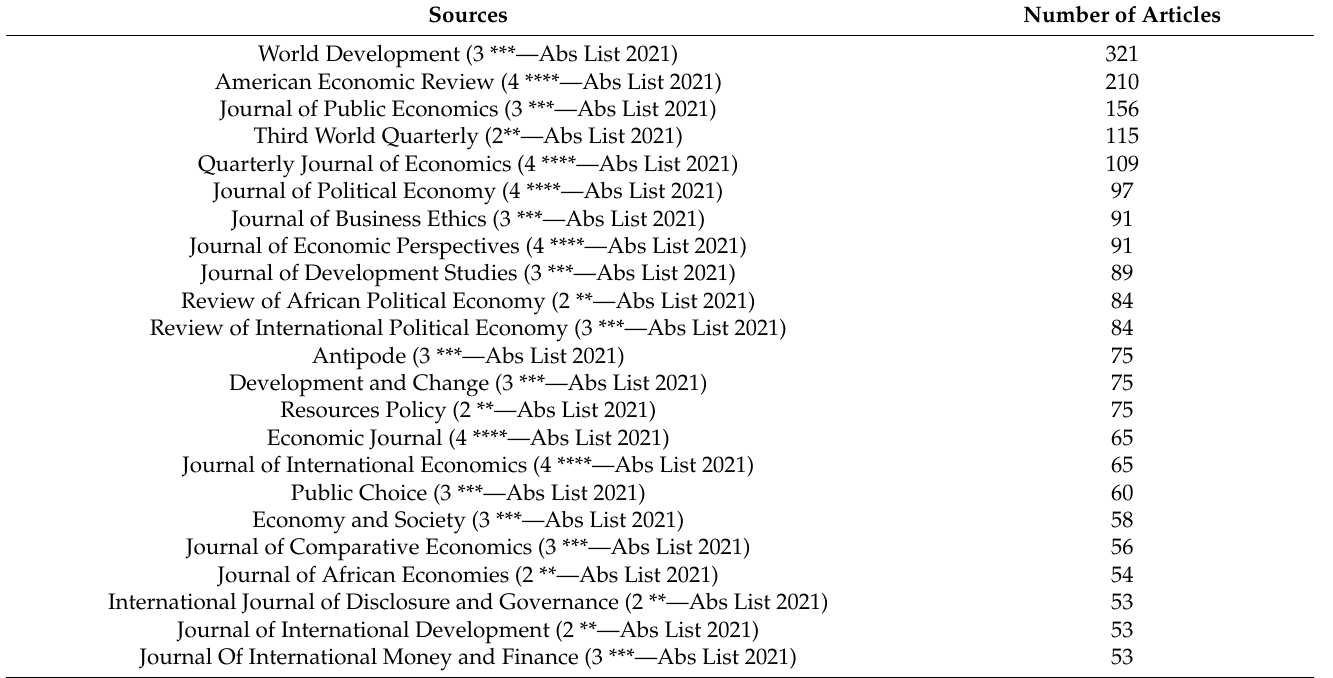
Table 2. The most relevant resources in the field of illicit practices and corruption in the financial sector.